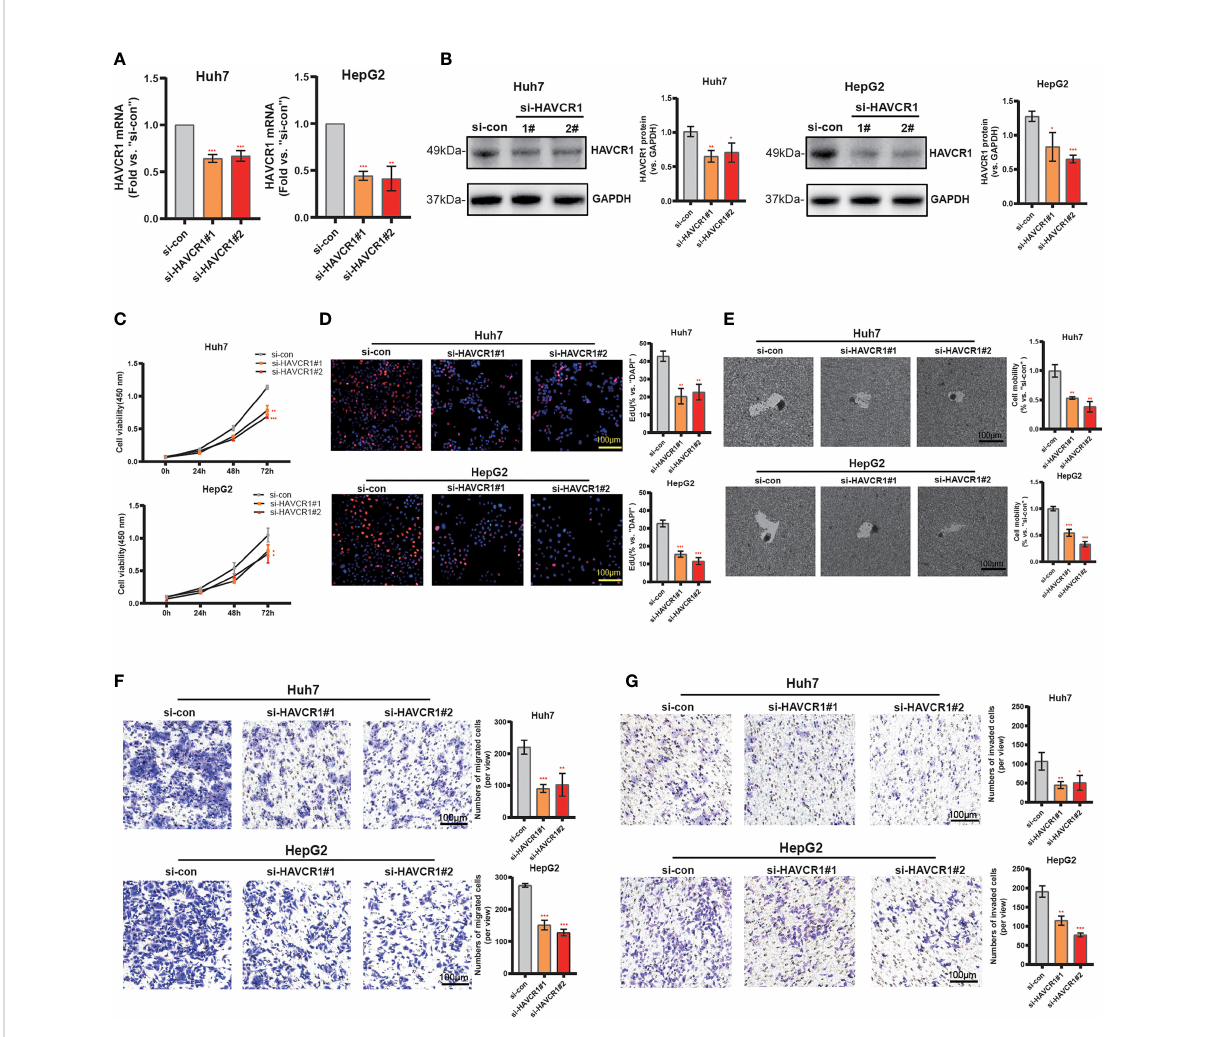
FIGURE 8 HAVCR1 Silencing Inhibits HCC Cell Proliferation, Migration, and Invasion. Established human HCC cell lines (HuH7 and HepG2) ( A – F ), bearing the HAVCR1 siRNA ( “ si-HAVCR1#1 ” and “ si-HAVCR1#2 ” ). qRT-PCR (A) and Western blotting (B) were employed for assessing the HAVCR1 mRNA and protein expression after si-HAVCR transfection. CCK-8 (C) and EdU assay (D) were used to test the proliferation of HuH7 and HepG2 cells. Phagokinetic track motility assay (E) was used measure the motility of cells. Cell migration and invasion were measured by “ Transwell ” (F)